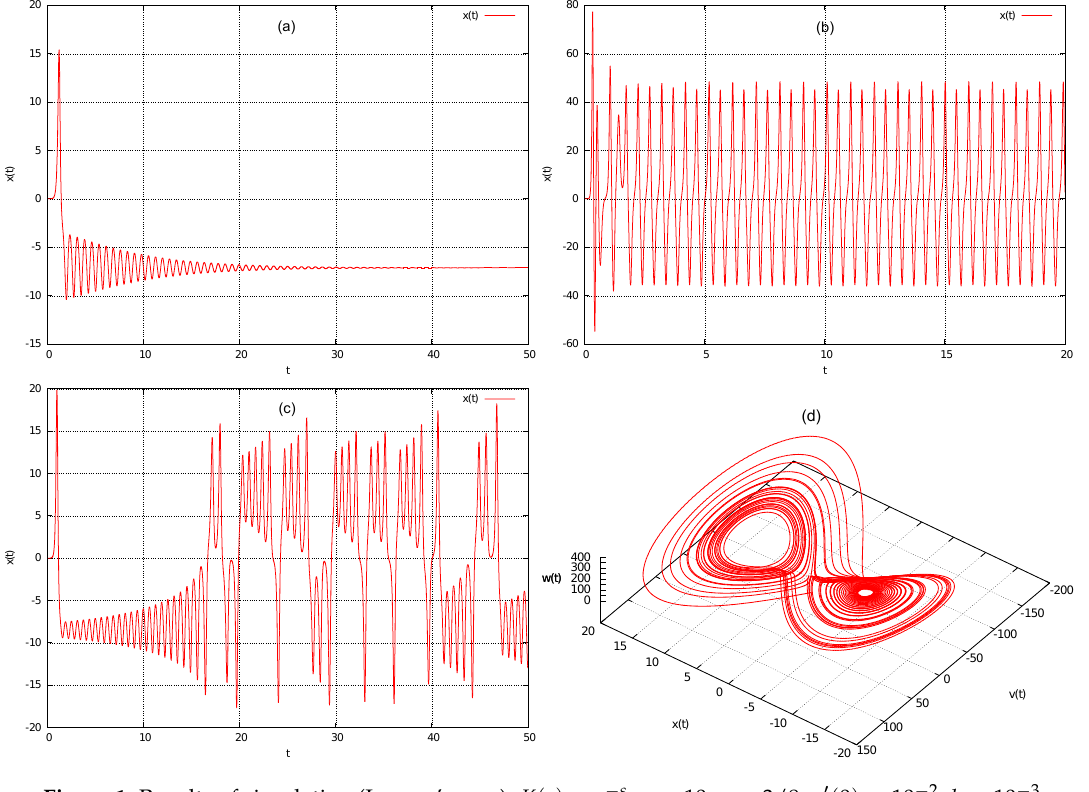
Figure 1. Results of simulation (Lorenz’s case): K ( s ) = e − s , σ = 10, p = 3/8, x (cid:48) ( 0 ) = 10 − 2 , h = 10 − 3 . ( a ) D = 20—asymptotically stationary regime; ( b ) D = 220—periodic regime; ( c ) D = 25—chaotic regime; ( d ) D = 25—chaotic